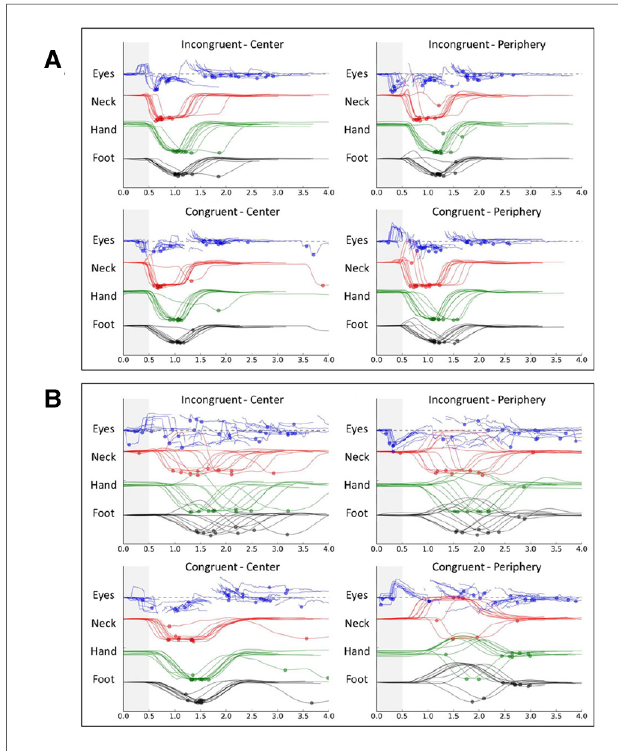
FIGURE 7 Graphic depiction of within-subject variability in response times for 40- trial virtual reality tests of 2 college football players: low variability ( A ) and high variability ( B